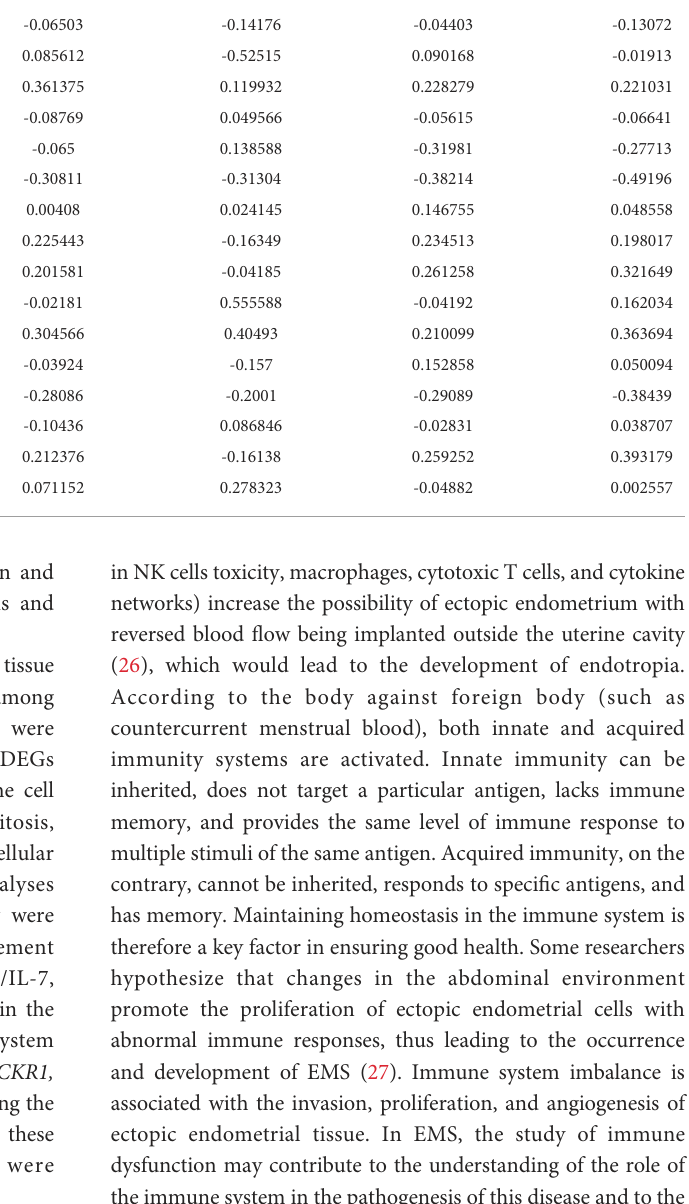
T cells CD4 memory